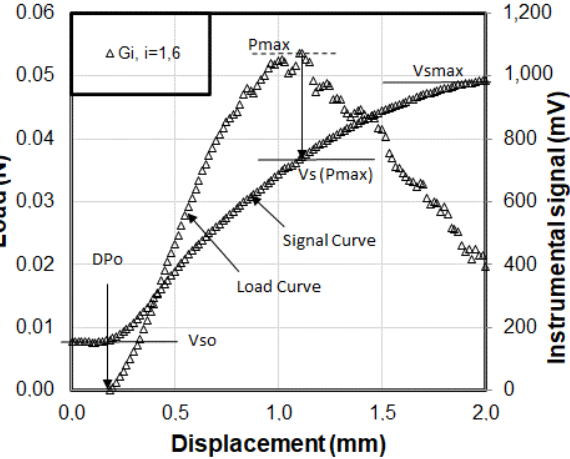
Figure 4. Generic parameters of the average load and instrumental signal curves from the bending tests.